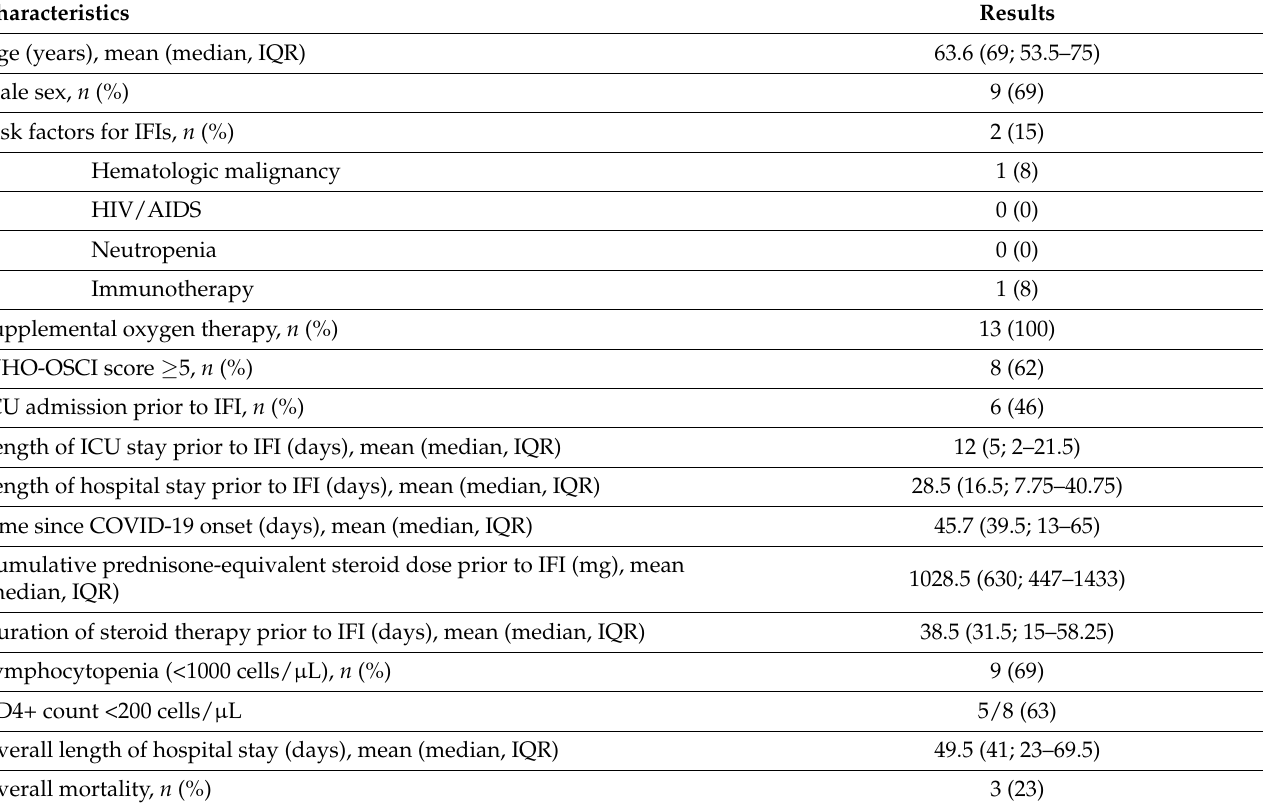
Table 2. Summary of the characteristics of the 13 COVID-19 patients who developed